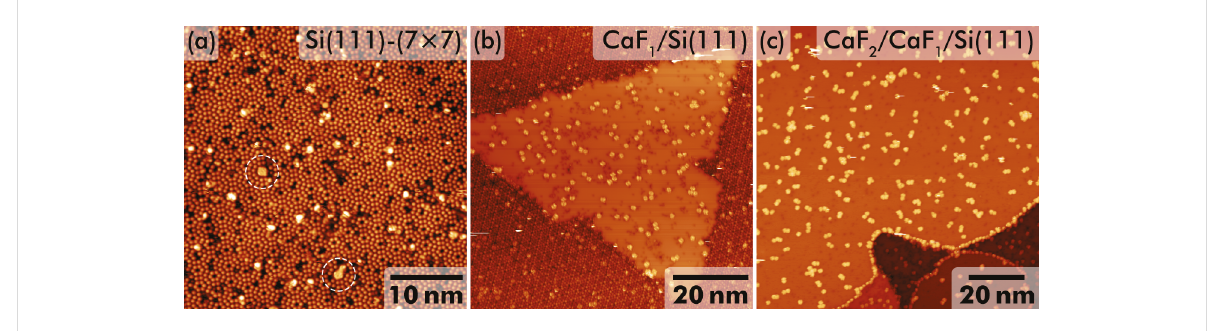
Figure 1: STM images of PTCDA molecules on (a) Si(111)-(7 × 7), (b) partly CaF 1 -covered Si(111), and (c) CaF 2 /CaF 1 /Si(111) surface areas. Imaging parameters: (a) dynamic STM, U b = 3.0 V, I t = 50 pA; (b) STM, U b = − 3.0 V, I t = 50 pA; (c) U b = − 3.0 V, I t = 50 pA.